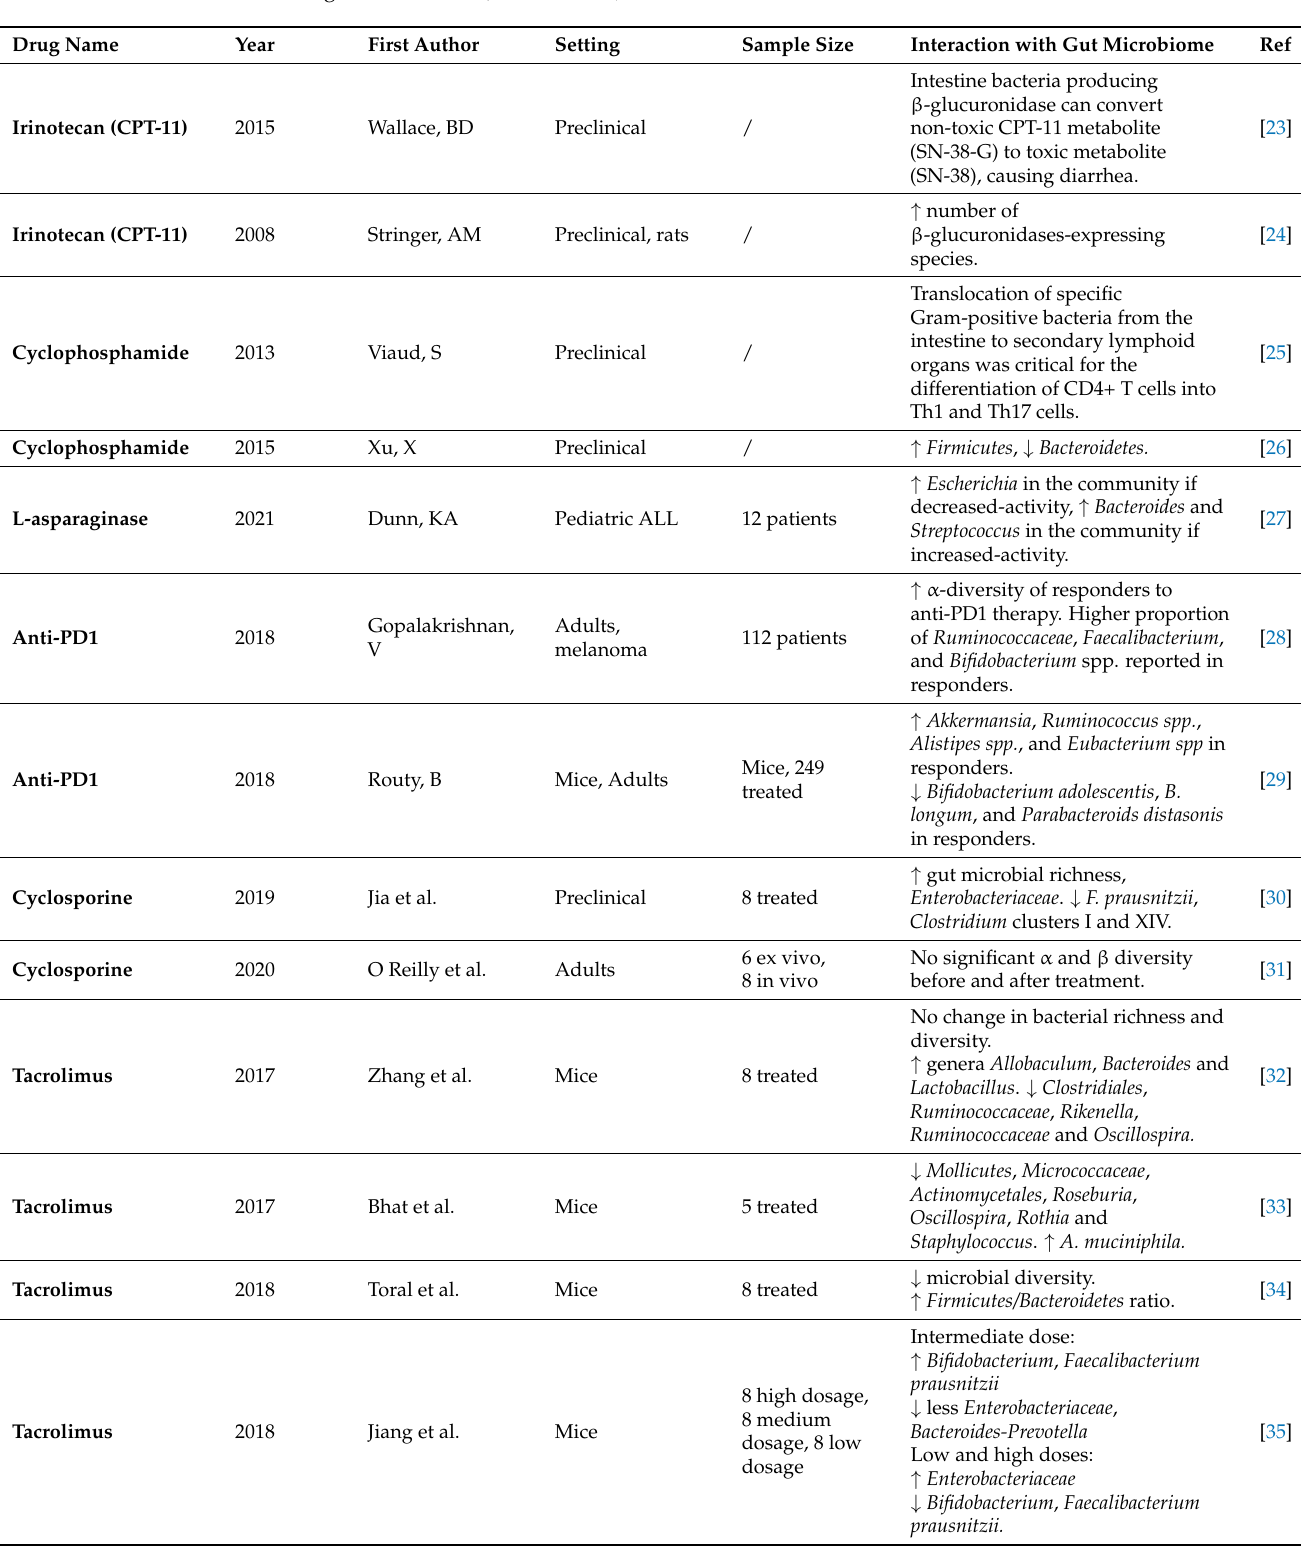
Table 1. Studies addressing the relationship between drugs commonly used in pediatric patients and gut microbiota. ↑ , increased; ↓ ,